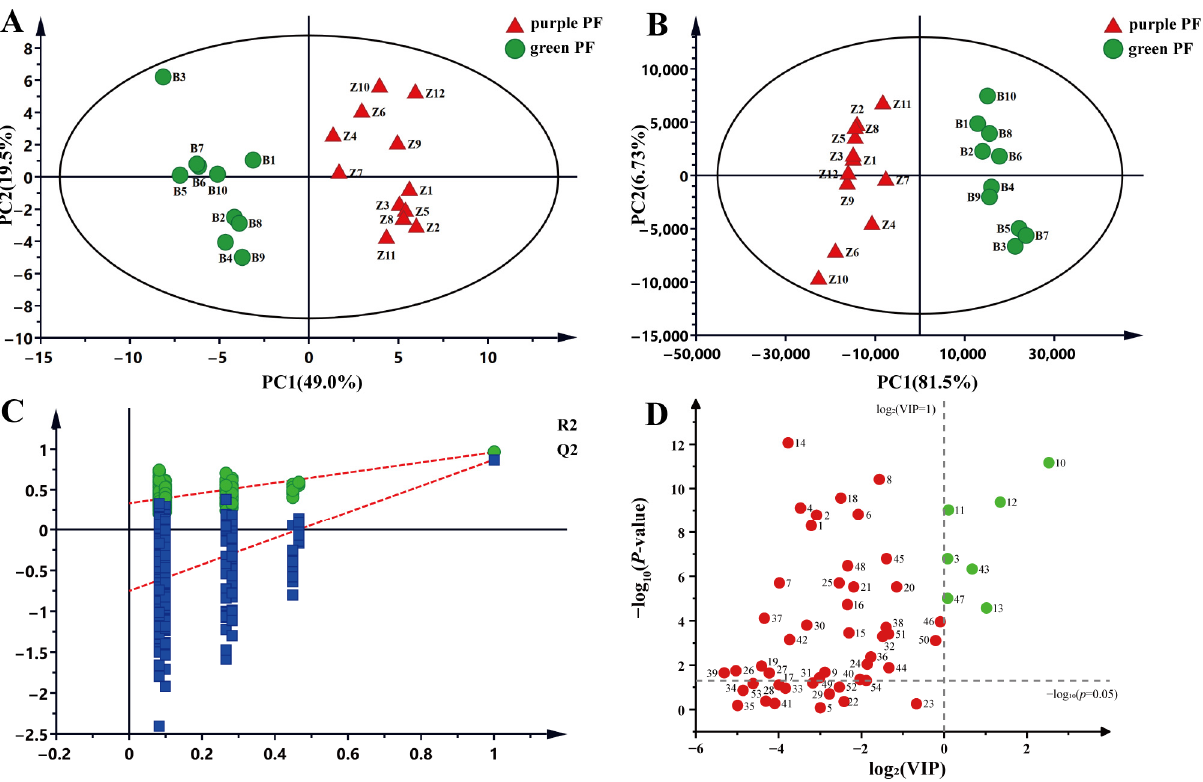
Figure 2. Determination of differential compounds from two PF varieties. ( A ) Unsupervised PCA score plot of purple and green PF samples. PC1 occupies 49.0% and PC2 19.5% of total variance. ( B ) Supervised OPLS-DA score plot of purple and green PF samples. PC1 occupies 81.5% and PC2 6.73% of total variance. ( C ) Permutation test at 200 times used for the discrimination between the two PF varieties. ( D ) Scatter plot of P -value and VIP value. The green points show differential compounds with VIP > 1, P < 0.05. Table 3. The relative peak areas (%) of the potential chemical markers in purple PF and green PF Retention No. Time (min)